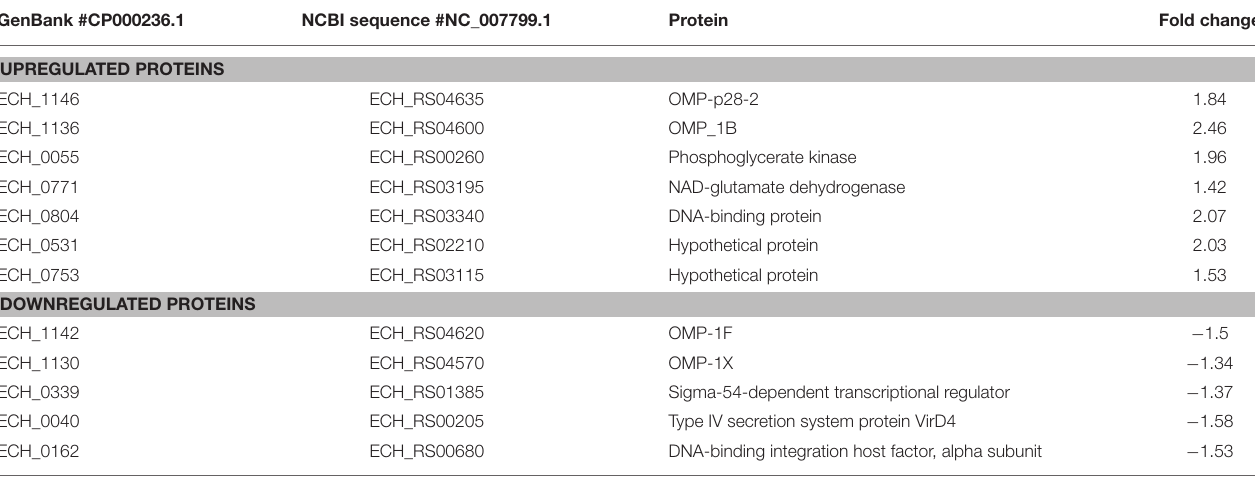
TABLE 2 | Proteins differentially expressed in mutant